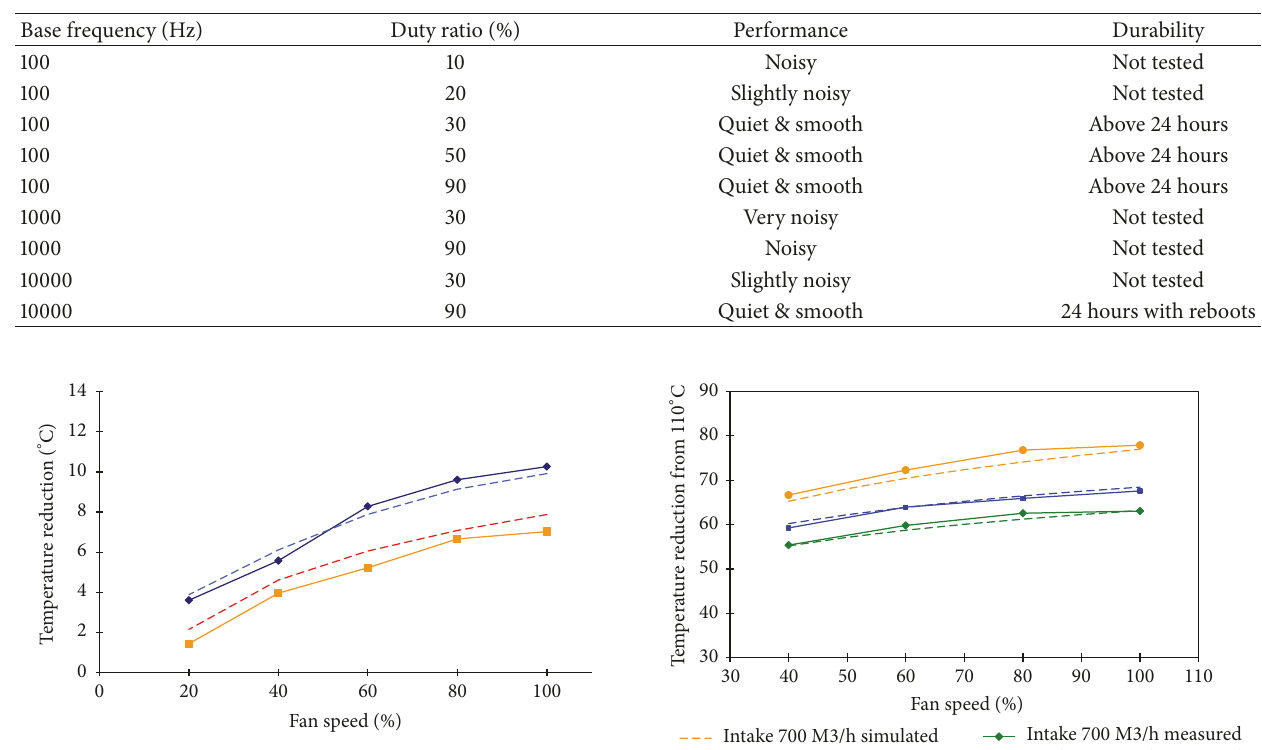
Figure 10: Actual fan and on-vehicle configurations for driving test. Table 1: PWM frequency and fan speed test results.